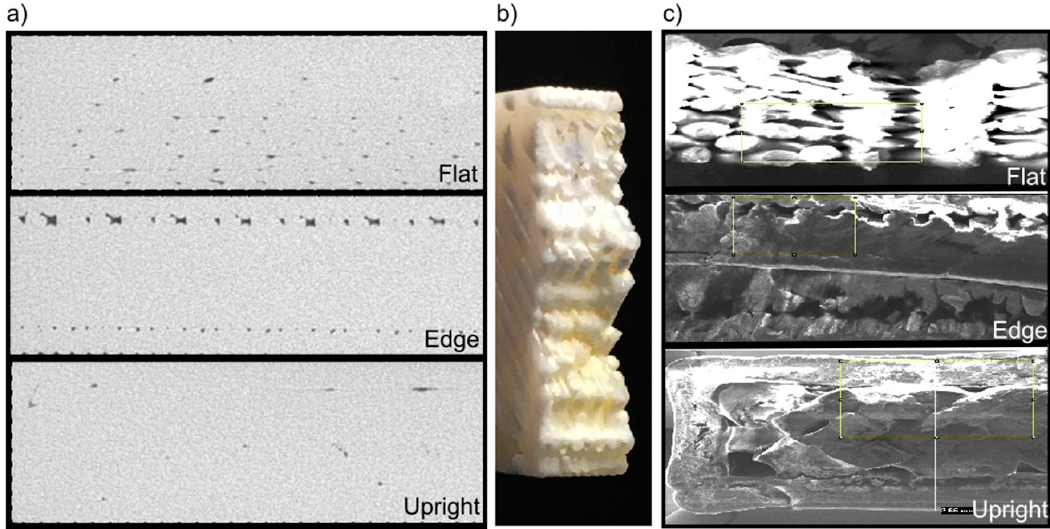
Figure 5. Transversal view of samples ( a ) f , e , and u of CT images before tensile test, ( b ) photo of the fracture on f sample, and ( c ) fracture on f , e , and u samples using electronic microscope.